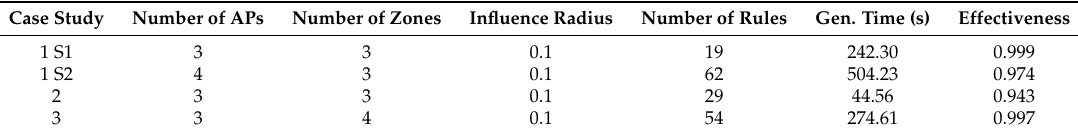
Table 14. Comparison table of three different case